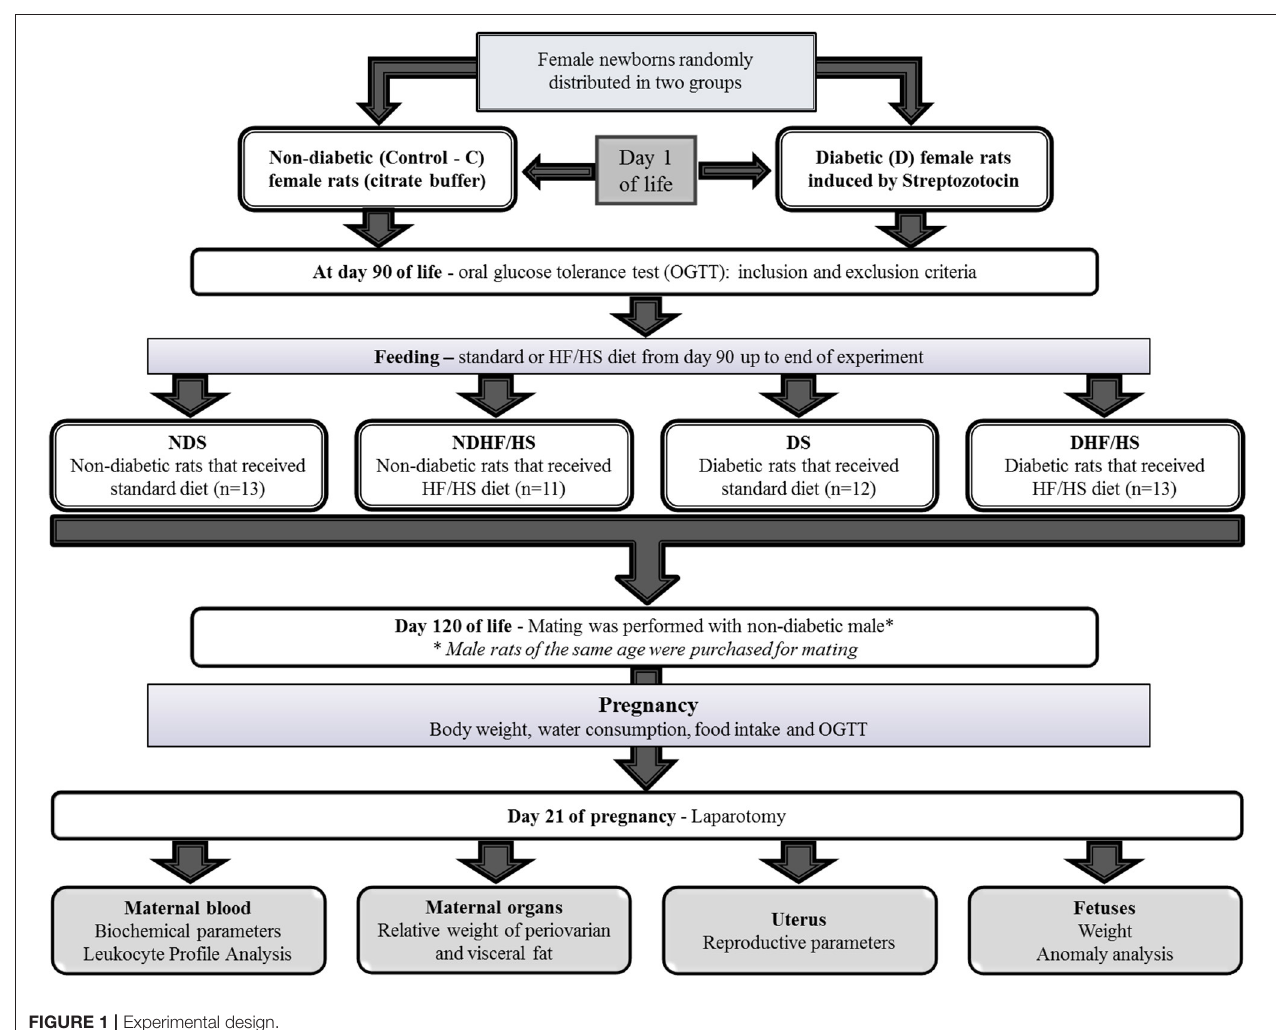
FIGURE 1 | Experimental design.